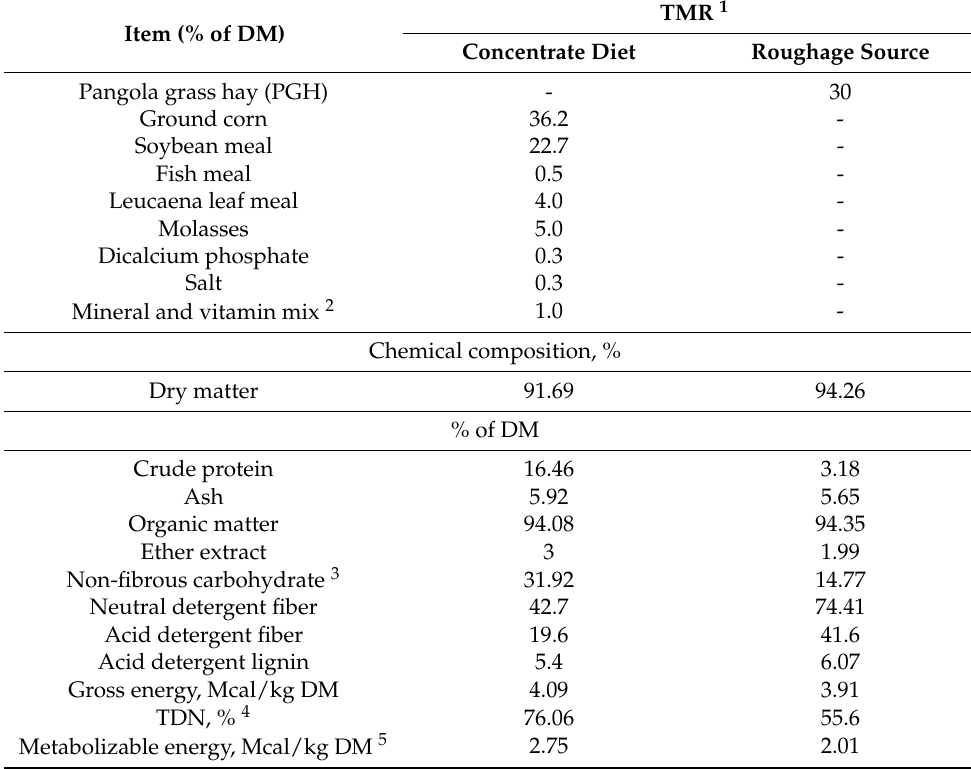
Table 1. Dietary ingredients and chemical composition of total mixed ration (TMR) and Pangola grass hay (PGH) fed to the goats during the trial. TMR 1 Item (% of DM) Concentrate Diet Roughage